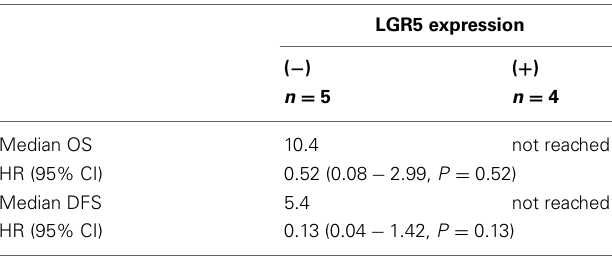
Table 3 | Correlation between LGR5 expression and